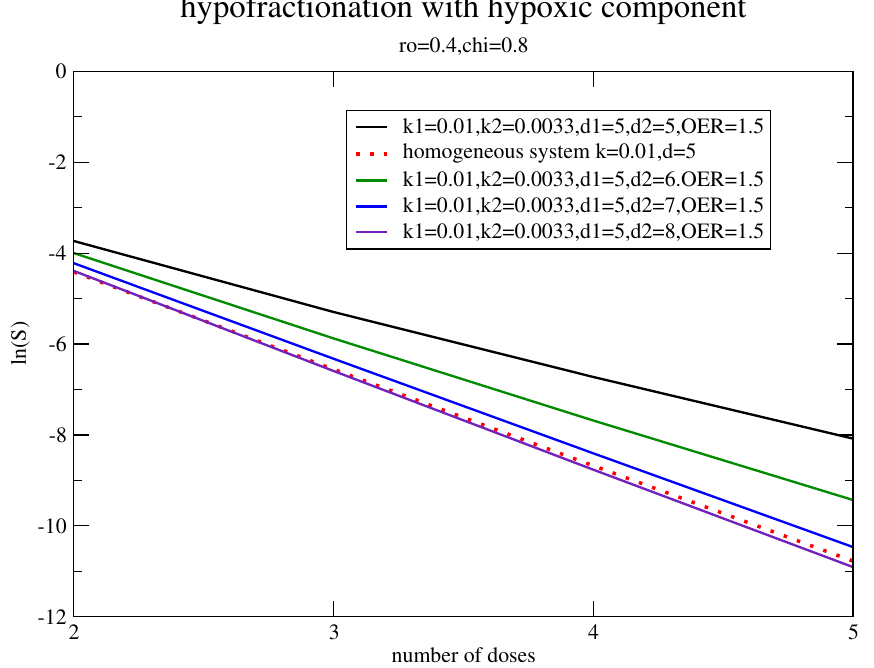
Figure 7. The survival fraction for hypofractionation with ρ = 0.4, χ = 0.8, k g ( 2 ) = 0.0033, k g ( 1 ) = k g = 0.01, α = 0.3 Gy ( − 1 ) , β = 0.03 Gy ( − 2 ) , and OER =